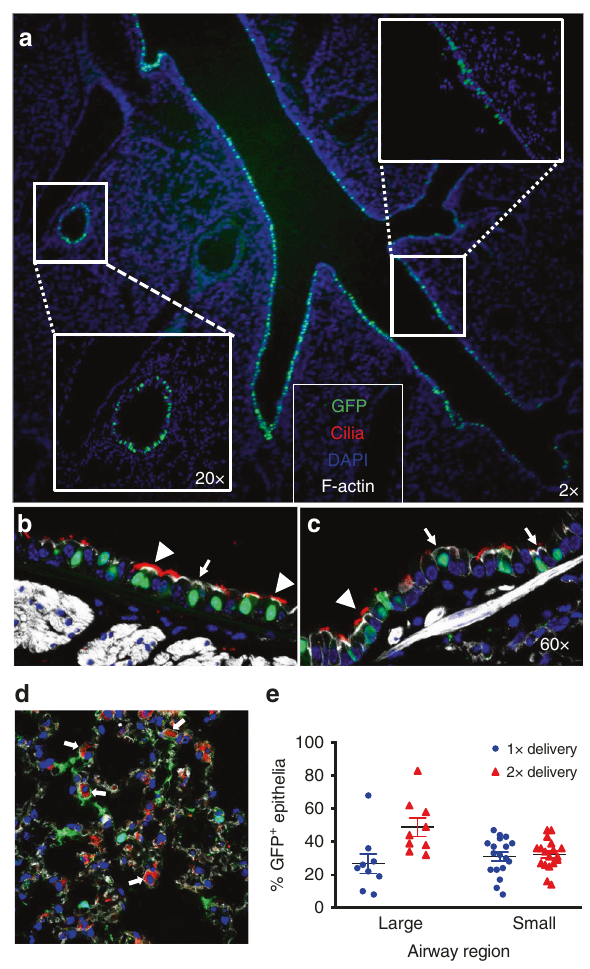
Fig. 3 GFP-NLS protein delivery to mouse airways using S10